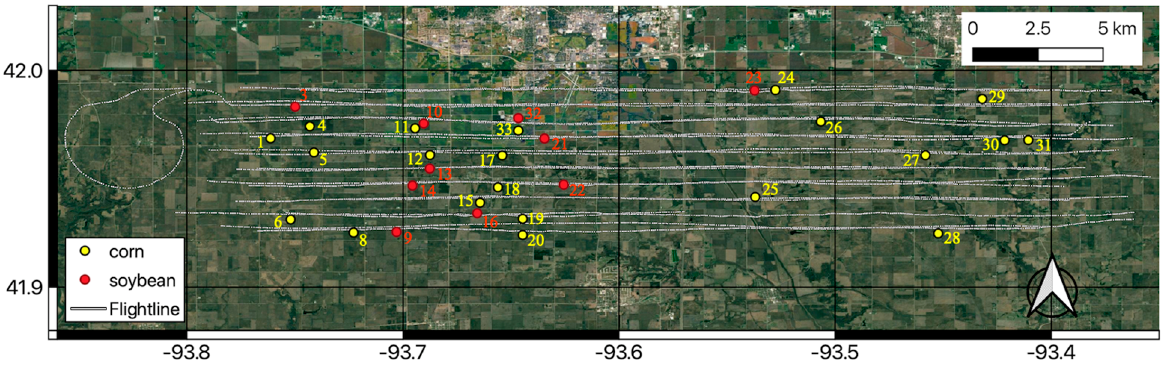
Figure 1. PALS flight lines on 25 June 2002, during SMEX02. There are 21 corn and 10 soybean fields. Site numbers are shown in numeric. It shows the location of recorded σ 0 and crop information for one day. Table 1. Sampling dates of backscattering coefficients (𝜎 (cid:2868) ) , soil moisture (𝑀 (cid:3049) ) , and vegetation wa- ter content (𝑉𝑊𝐶) ; highlight for overlapping dates.